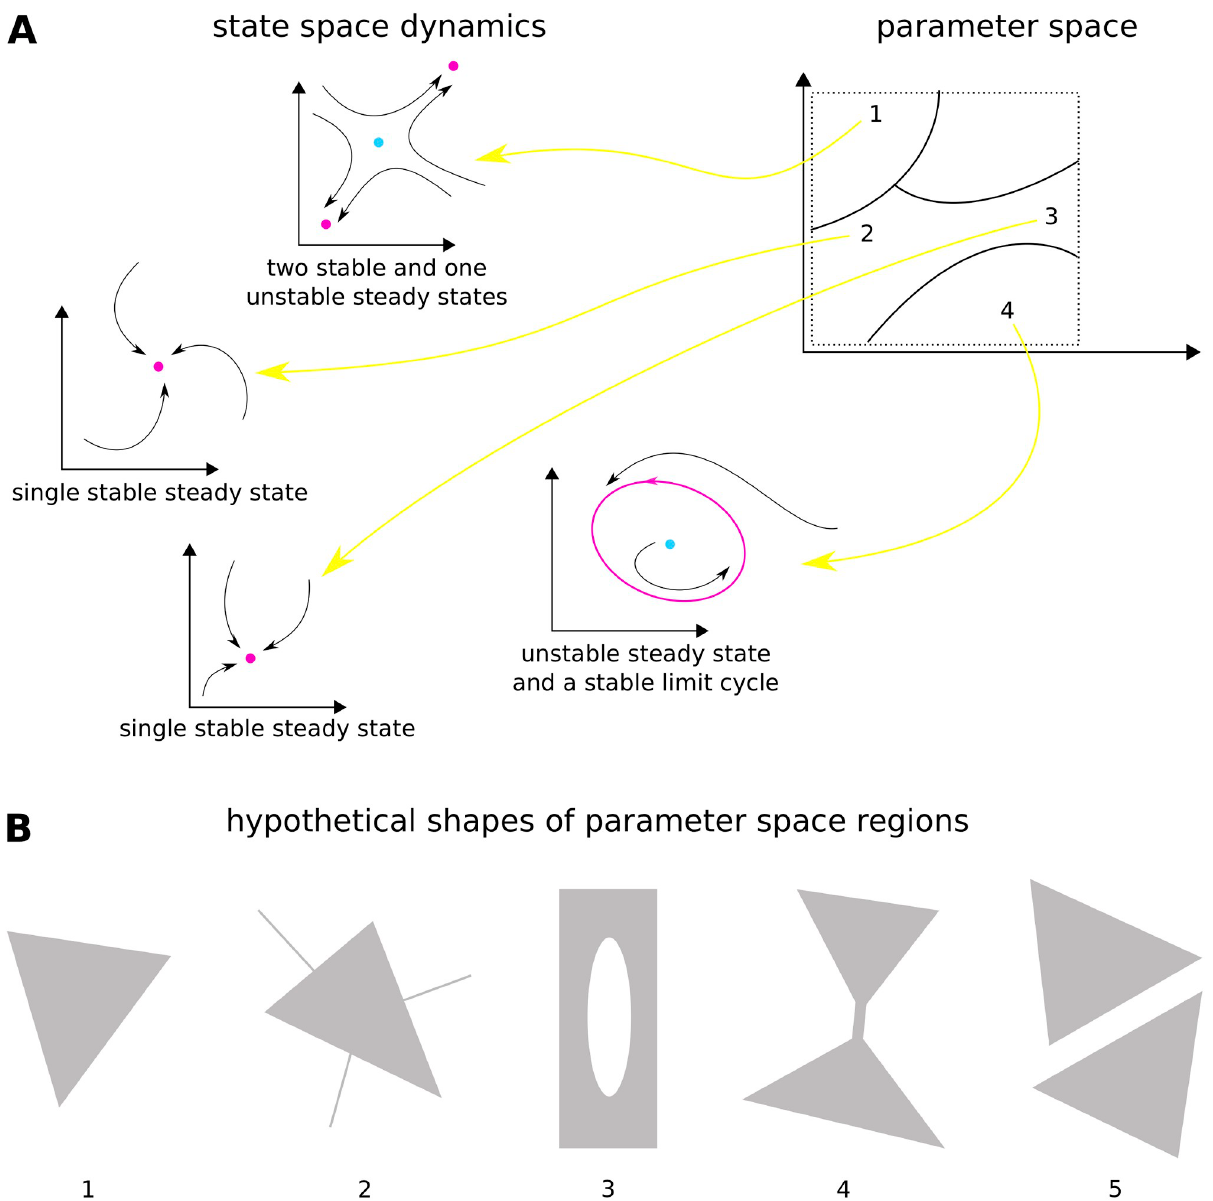
Fig 1. Models and their parameter geography. A: Behaviour of a hypothetical mathematical model, as in a system of ordinary differential equations. When a point is chosen in the parameter space (right), indicated by a number 1, ... , 4, a dynamics takes place in the state space (left), shown by the trajectories with arrowheads. The state space and parameter space are shown here as 2-dimensional but could be of any dimension. The parameter space is expected to break up into regions, shown here within a box of finite volume (dotted boundary) following the method adopted in the paper, such that the dynamics remains qualitatively similar within each region, as for parameter points 2 and 3, and becomes qualitatively different between regions. Parameter point 1 gives bistability in the dynamics, parameter points 2 and 3 give monostability, and parameter point 4 gives a stable limit cycle. Stable attractors are magenta; unstable attractors are cyan. B: Hypothetical shapes of regions in parameter space, assumed to be within a finite volume in two dimensions. All except region 2 have nonzero volume in two dimensions in the vicinity of each point. Region 1 is convex; region 2 has one-dimensional subregions, which would not be detectable by random sampling in two dimensions; region 3 has a hole in its interior; region 4 has a narrow “neck;” region 5 is disconnected.